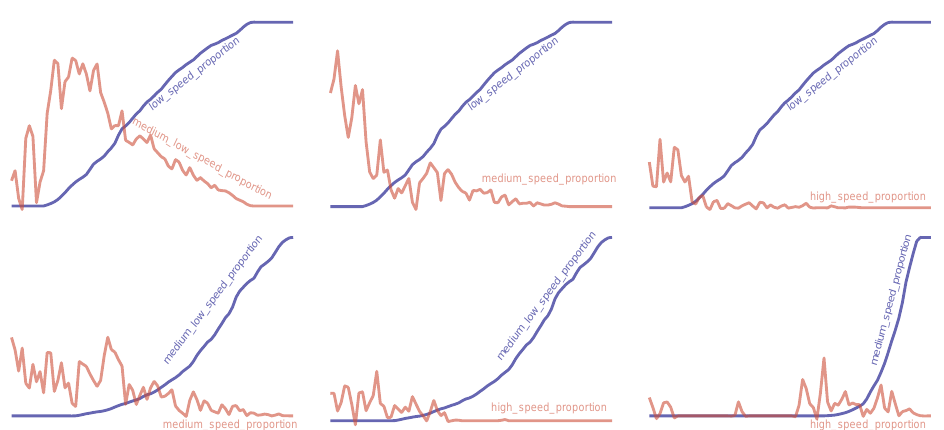
Figure 9. A portrayal (with a 5% smoothing) of the weak monotone relationships between the pairs of speed proportion descriptors in the kinematic descriptor-based model.